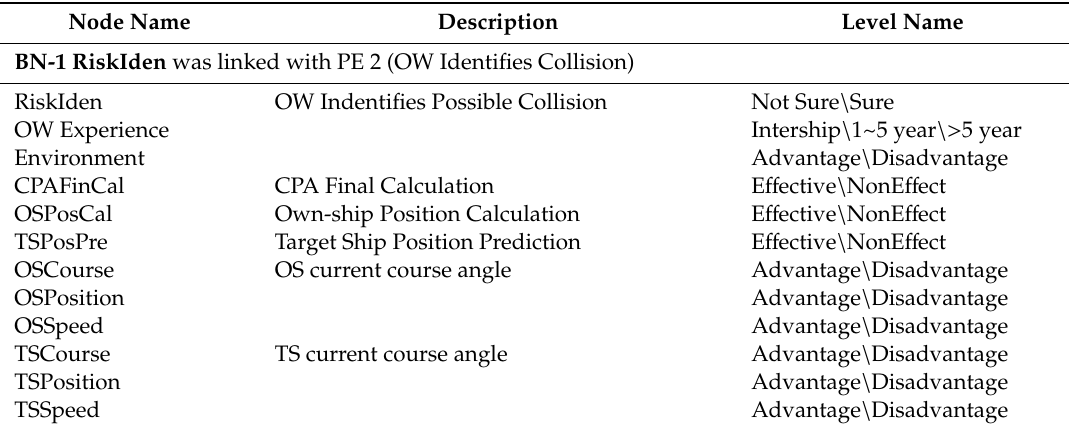
Table 2. Descriptions and Level labels of the